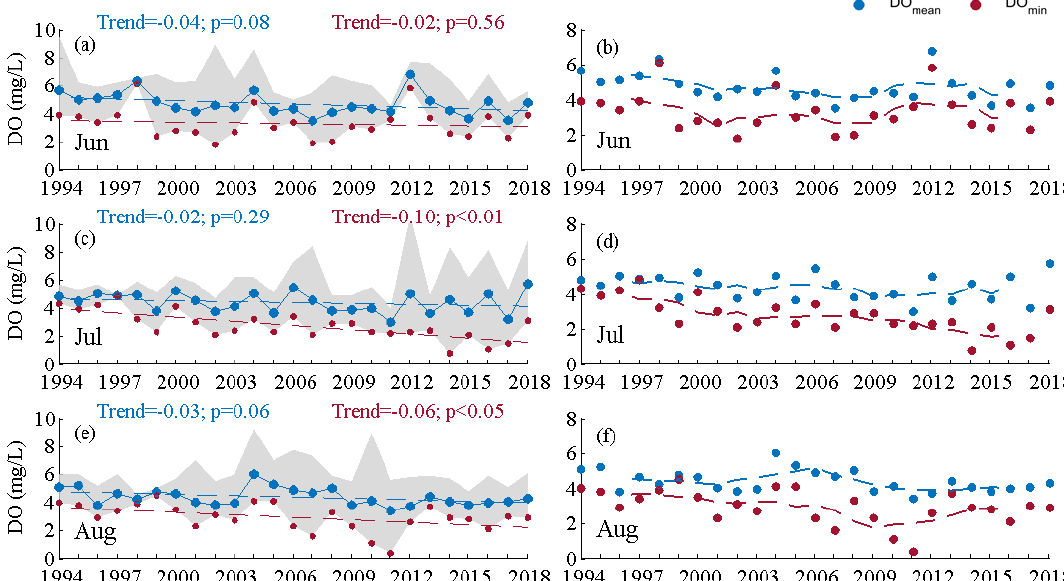
Figure 6. Mean and minimum concentrations of dissolved oxygen (DO) at the bottom with their long-term trends (a, c, e) and with 5-year sliding mean values (b, d, f) in summer months during 1994–2018. Note that the gray patches represent the range of DO observed in the 10